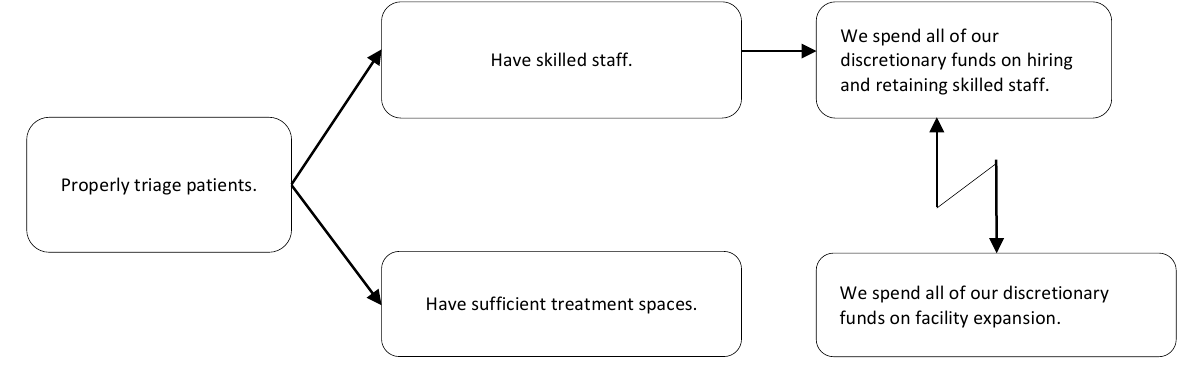
Figure 2. Evaporative Cloud of Goldratt’s Theory Applied to the Problems Associated with an Emergency Department at a